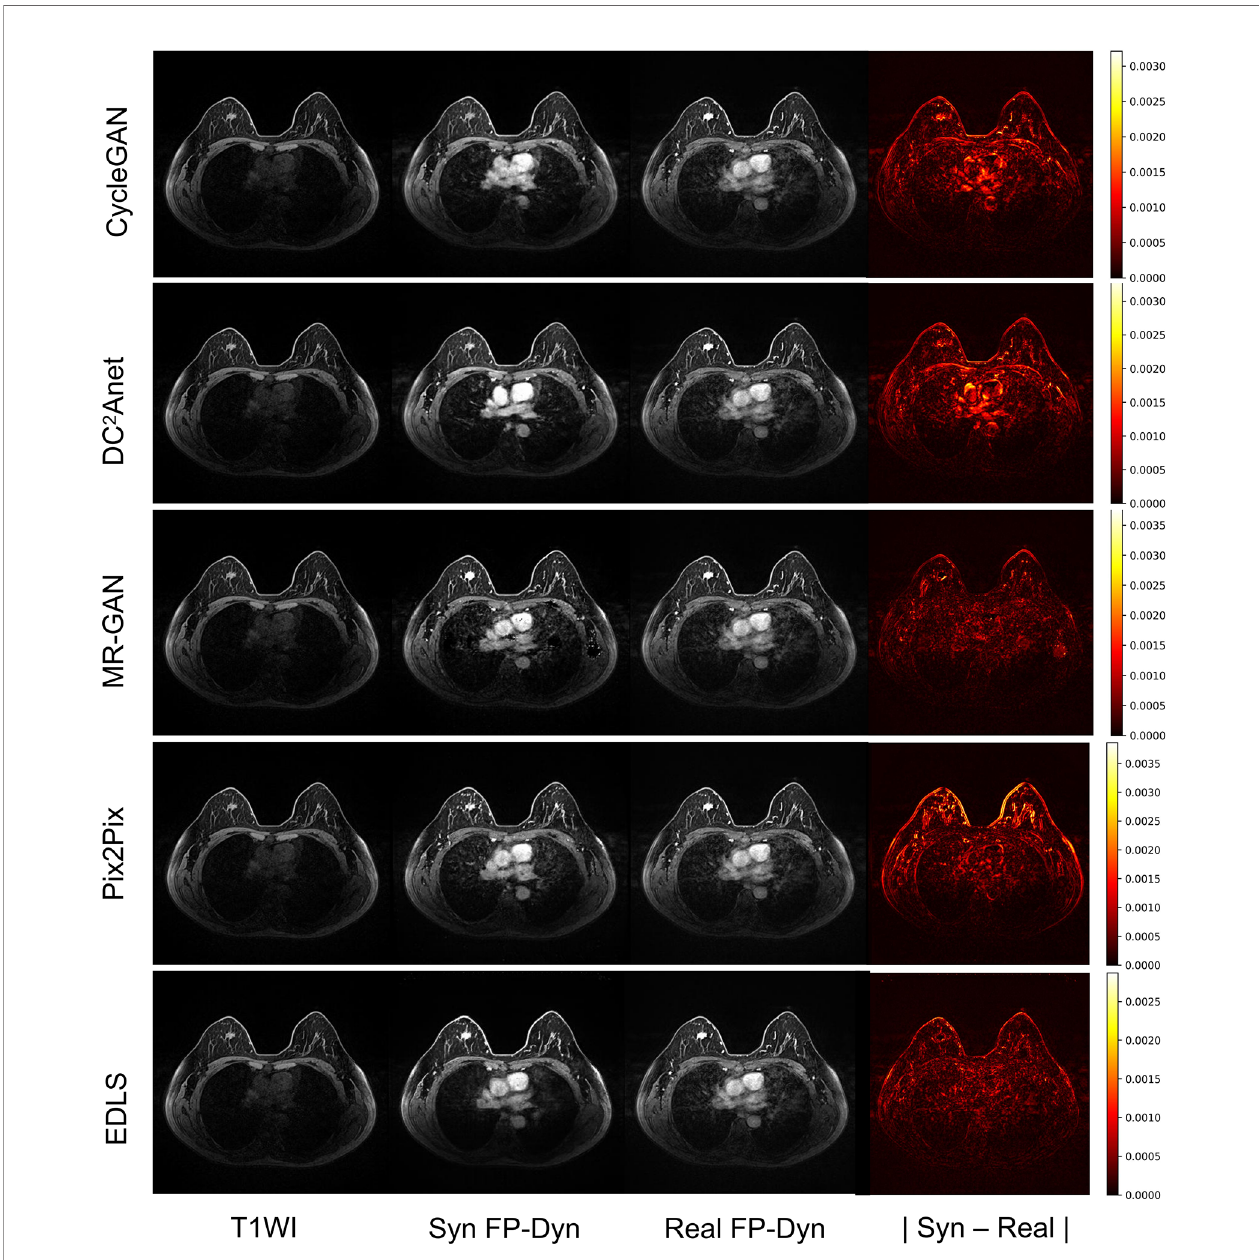
FIGURE 3 | Sample images of the T1WI images, synthesized FP-Dyn images, original FP-Dyn images, and absolute error images. From left to right: T1WI breast MR images, synthesized FP-Dyn images, original FP-Dyn breast MRI, and absolute error